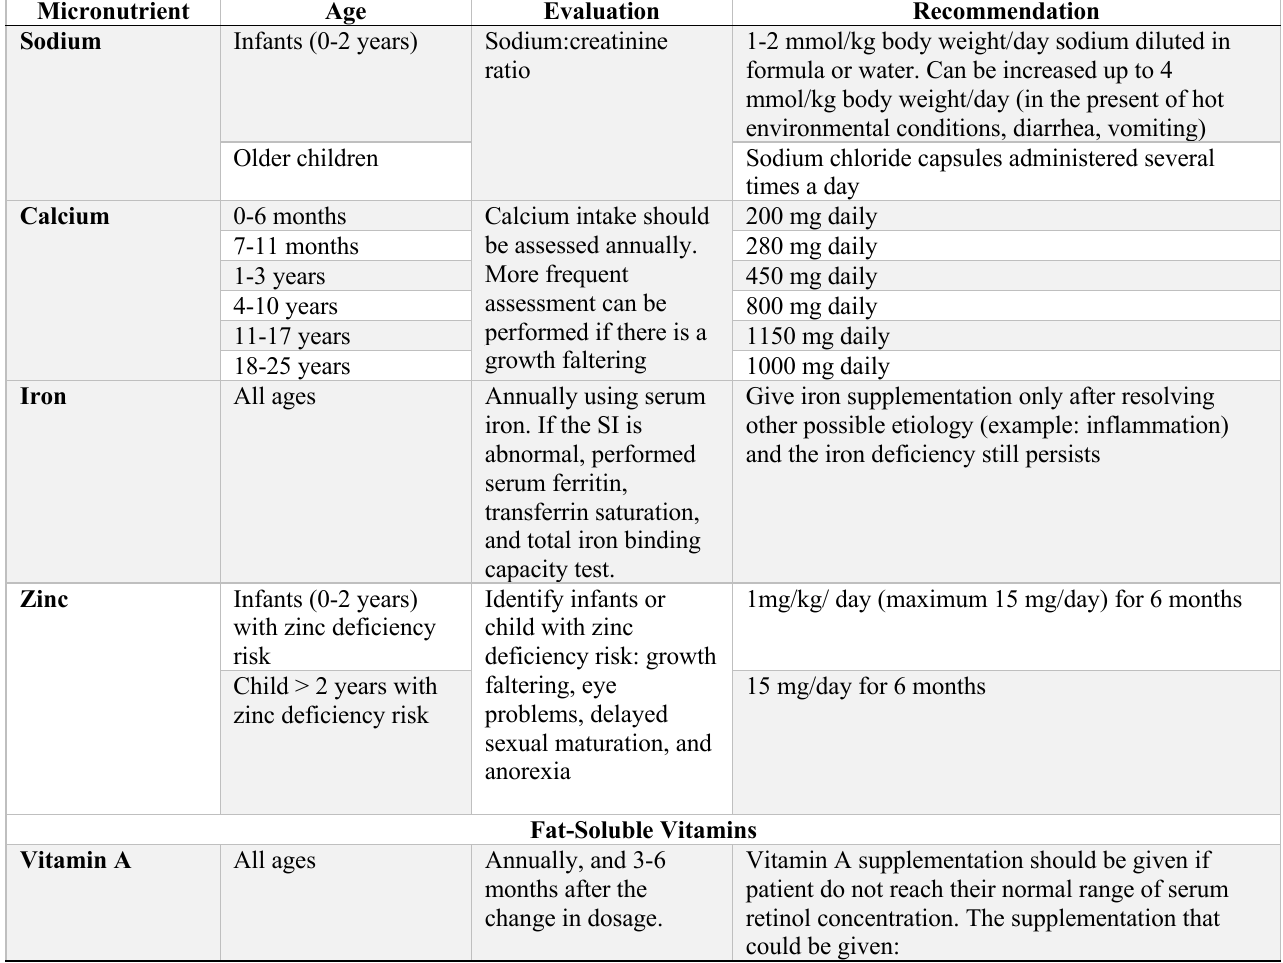
Table 2. The summary of micronutrient recommendation in CF patient 11